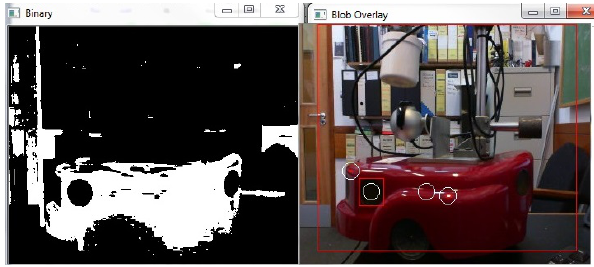
Figure 9: The left image is binary version arising from HSV and RGB segmentation of the original. The right image is original with blobs selected from binary overlaid. In this instance there is relative poor identification of the main object of interest (the red AmigoBot with the omnidirectional camera)